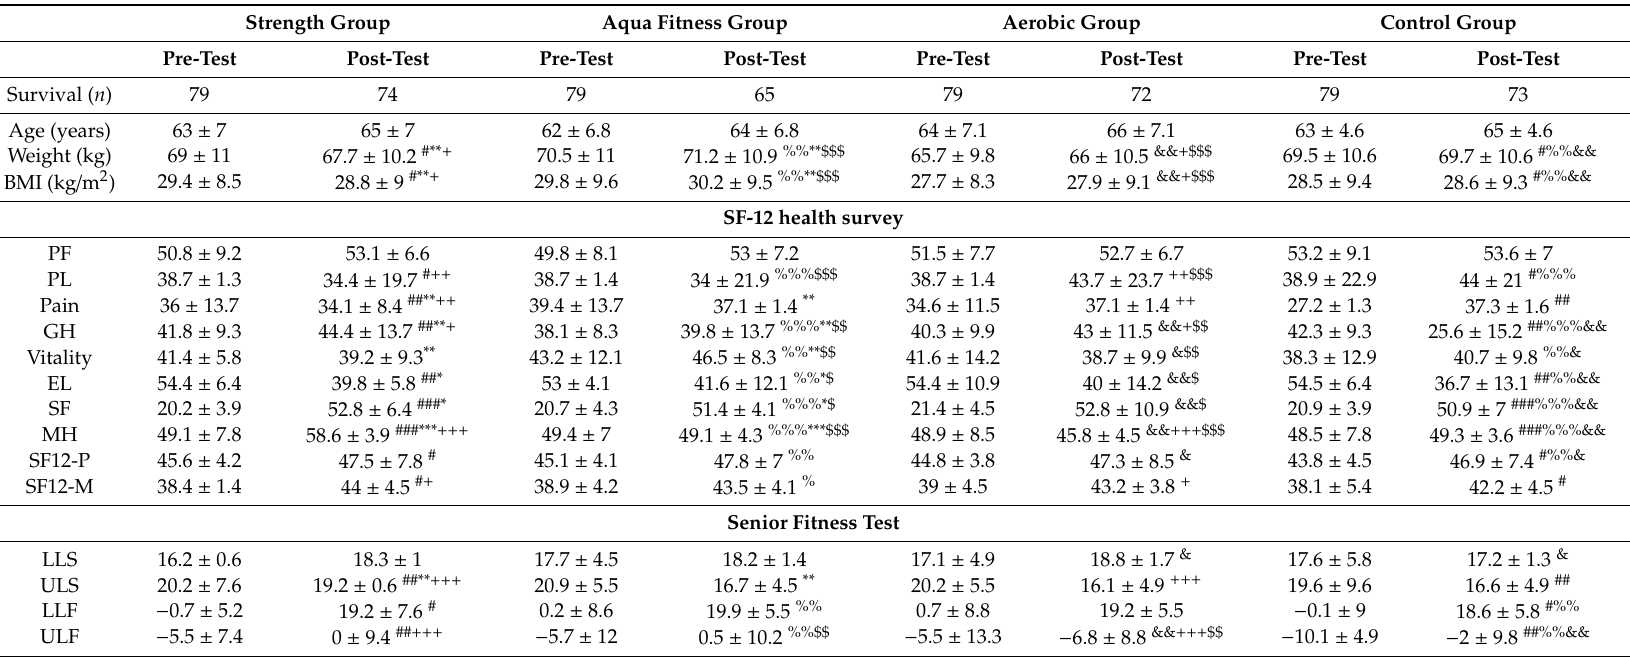
Table 1. Descriptive analysis of the sample by groups (mean ± standard